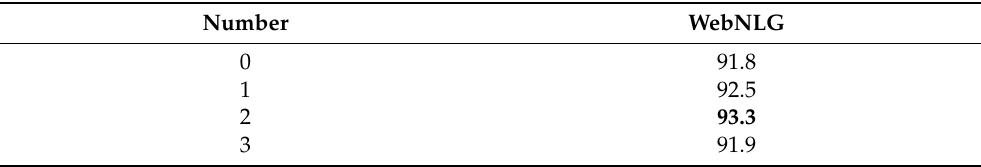
Table 6. F1 (%) of different numbers of entity and relation heterogeneous graph attention network layers.